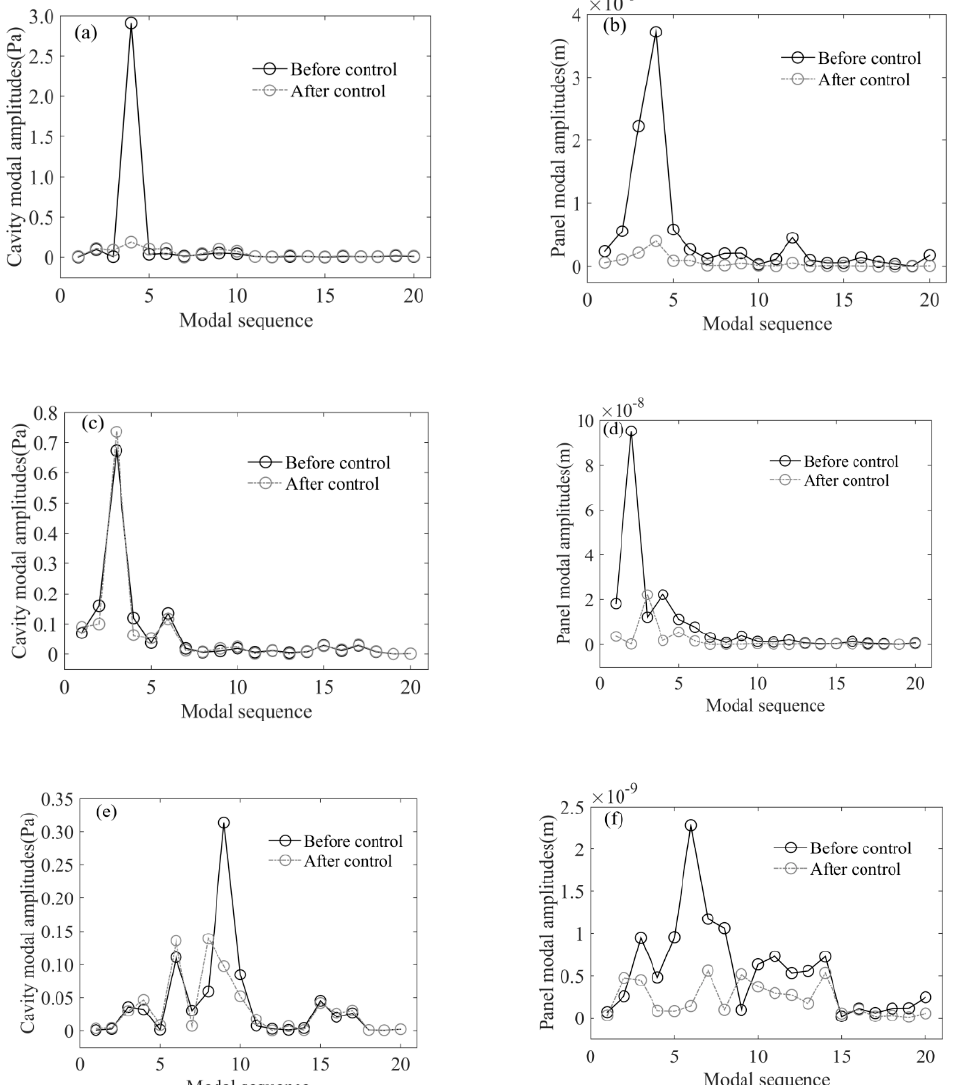
Figure 7. Modal amplitudes of the first twenty modes before and after control when f = 248 Hz (Case 1), f = 161 Hz (Case 2), and f = 439 Hz (Case 3). ( a , c , e ) ( a ) Cavity modes for Case 1, ( c ) Cavity modes for Case 2, ( e ) Cavity modes for Case 3. ( b , d , f ) ( b ) Base plate B modes for Case 1, ( d ) Base plate B modes for Case 2, ( f ) Base plate B modes for Case 3.